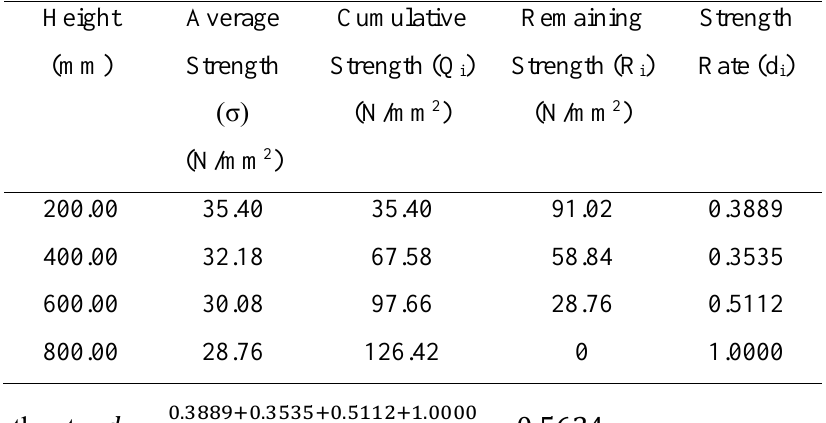
Strength Analysis of Iroko